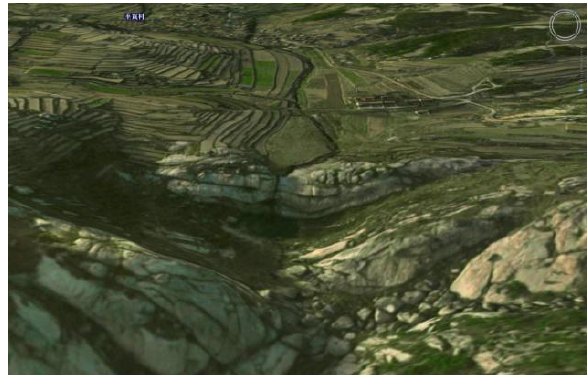
Figure 15. Juyushan